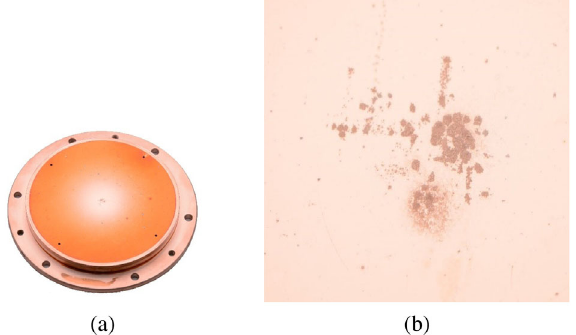
FIG. 22. (a) Picture of a used copper photocathode showing laser-induced damage in the active area at the center. (b) Optical microscopy image of the central damaged region.